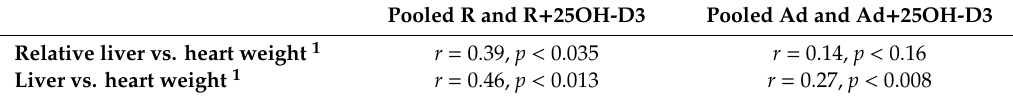
Figure 2. Time course of changes in absolute and relative heart and liver weights in di ff erent diet groups of broiler breeder hens experiencing sudden death. Hens experiencing sudden death (n = 19, 12, 78, and 57 in R, R + 25-OH-D3, Ad, Ad + 25-OH-D3 group, respectively) were necropsied within 24 h to determine body composition including actual (panels A , B ) and relative (to their own bodyweight, panels C , D ) heart and liver weight as a continuous variable along the time course (dash lines indicate linear regression). R; restriction, Ad; ad libitum, 25-OH-D 3 ; 25-hydroxycholecalciferol. Table 2. Correlation of heart and liver weight in broiler breeder hen sudden death